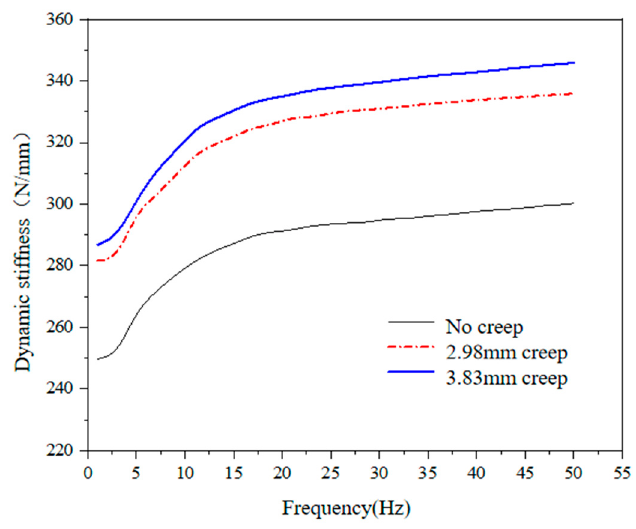
Figure 13. Dynamic stiffness curves of suspension main springs under different creep conditions.